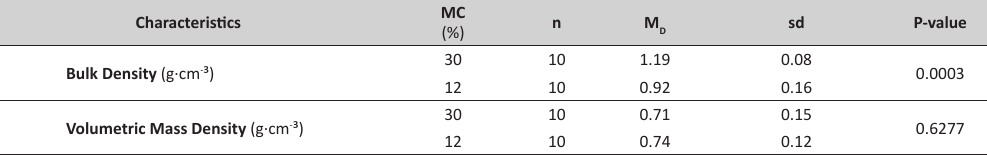
TAble 2. Eucalyptus maidenii wood densities.